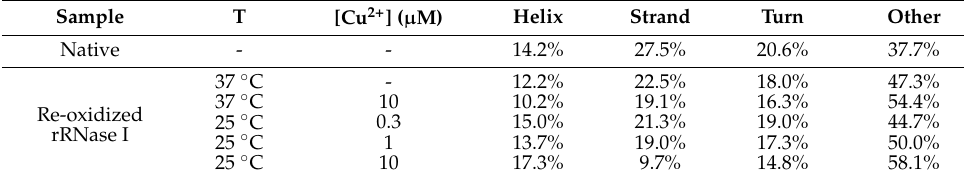
Table 2. Secondary structure analysis of the CD spectra of re-oxidized rRNase